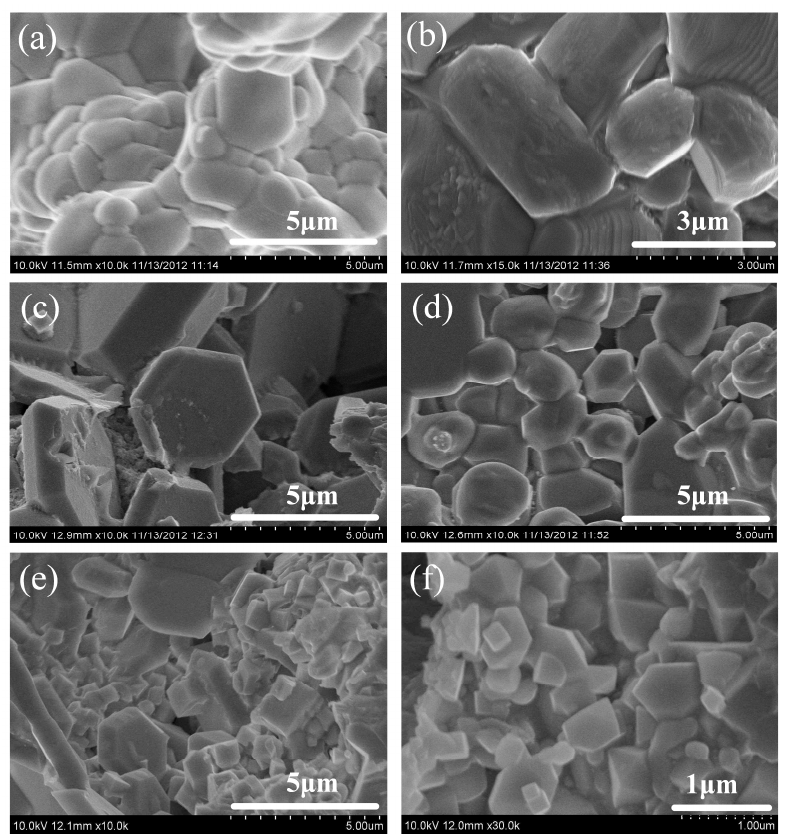
Figure 7. Microstructures of the SHS products with the reactant Ni contents of ( a ) 0 wt.%, ( b ) 10 wt.%, ( c ) 20 wt.%, ( d ) 30 wt.%, ( e ) 40 wt.%, and ( f ) 50 wt.%.